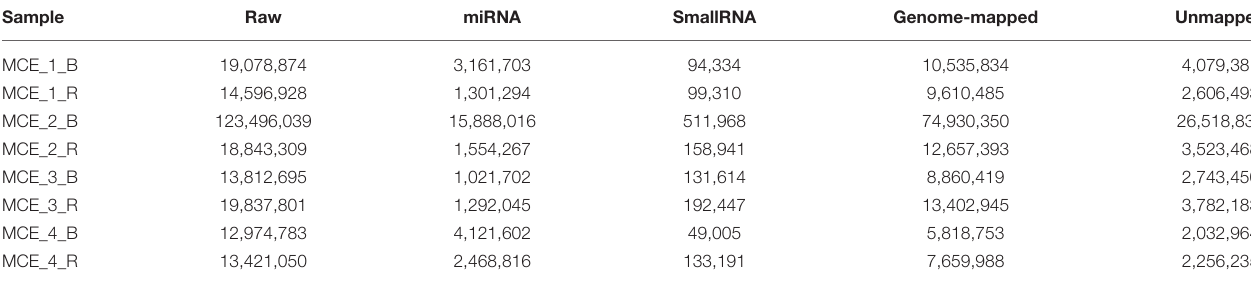
TABLE 2 | Summary statistics of sequencing, mapping and abundance on genomic features. Sample